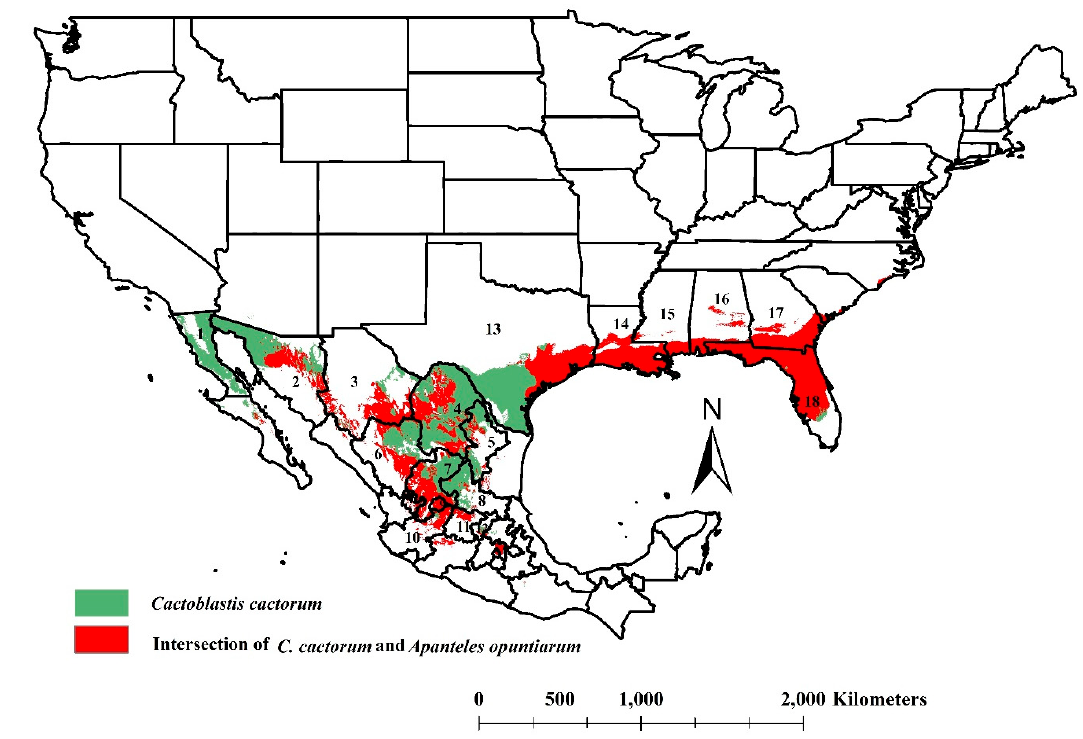
Figure 4. Intersection of ecological niches for Cactoblastis cactorum and its natural enemy Apanteles opuntiarum (red color) in North America. Areas in green are the ecological niche of the C. cactorum that would not intersect with A. opuntiarum . State designations for Mexico includes (1) Baja California, (2) Sonora, (3) Chihuahua, (4) Coahuila, (5) Nuevo Leon, (6) Durango, (7) Zacatecas, (8) San